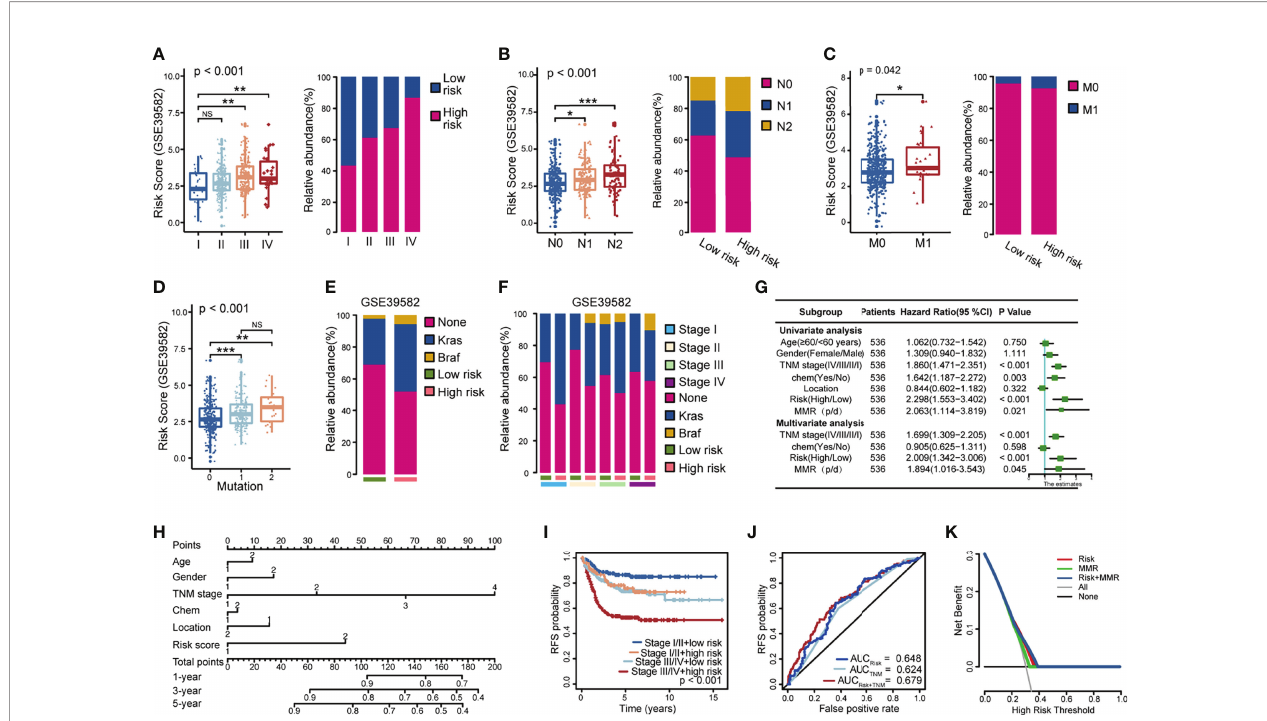
FIGURE 4 | Correlation between the model and clinicopathological characteristics in the GSE39582 dataset. (A – C) Correlation between risk score and TNM stage (A) , lymphatic metastasis (B) , distant metastasis (C) ; (D-F) Relationship between risk score and KRAS and BRAF tumor mutations, 0: None mutation: 1: KRAS mutation; 2: BRAF mutation; (G) Univariate and multivariate COX regression models showed that the relapse model was an independent prognostic factor; (H) Relapse risk nomogram based on clinical characteristics; (I) The combined tumor stage and risk score could effectively assess early relapse; (J) The ROC curve assessed the prognostic accuracy of the TNM staging and the risk score; (K) DCA analysis for risk score, MMR and the two combined model. NS, Not Signi fi cant; *p < 0.05; **p < 0.01; ***p <